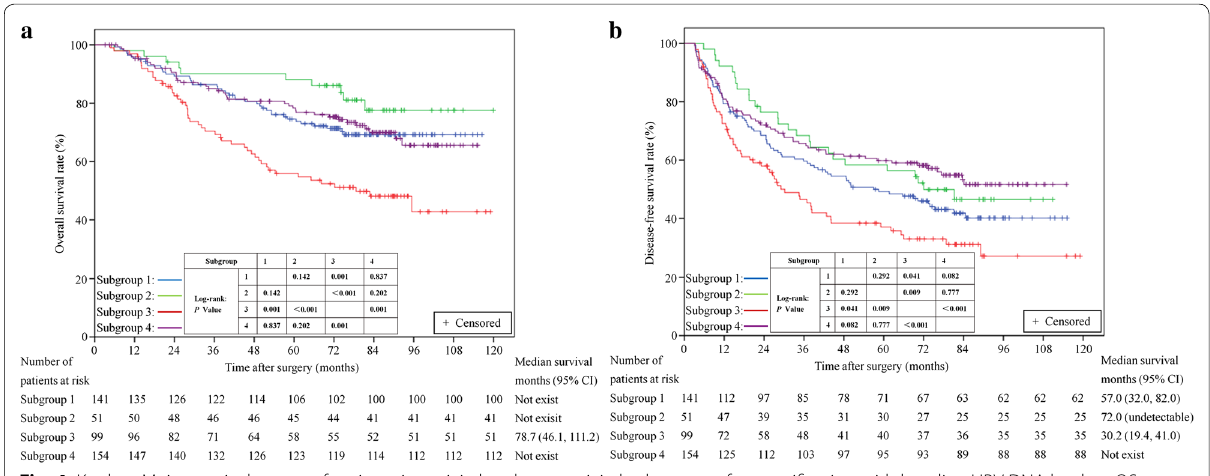
Fig. 4 Kaplan–Meier survival curves of patients in antiviral and non‑antiviral subgroups after stratification with baseline HBV DNA loads. a OS rates among the four subgroups of patients (log‑rank test: subgroup 3 vs. subgroup 1,